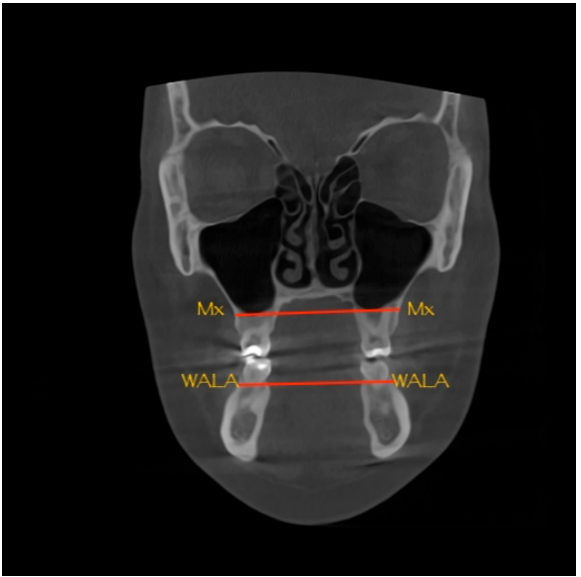
Figure 2. UPCBCT analysis: Mx-Mx and WALA-WALA distances.